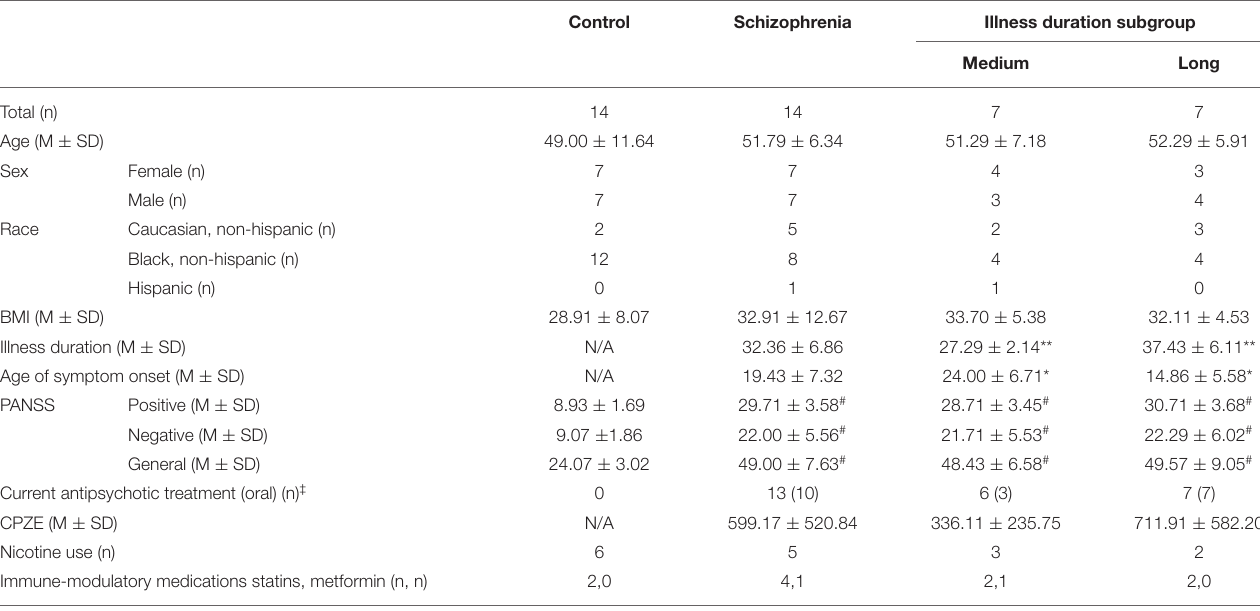
TABLE 1 | Participant demographics and clinical characteristics for primary and subgroup analyses.